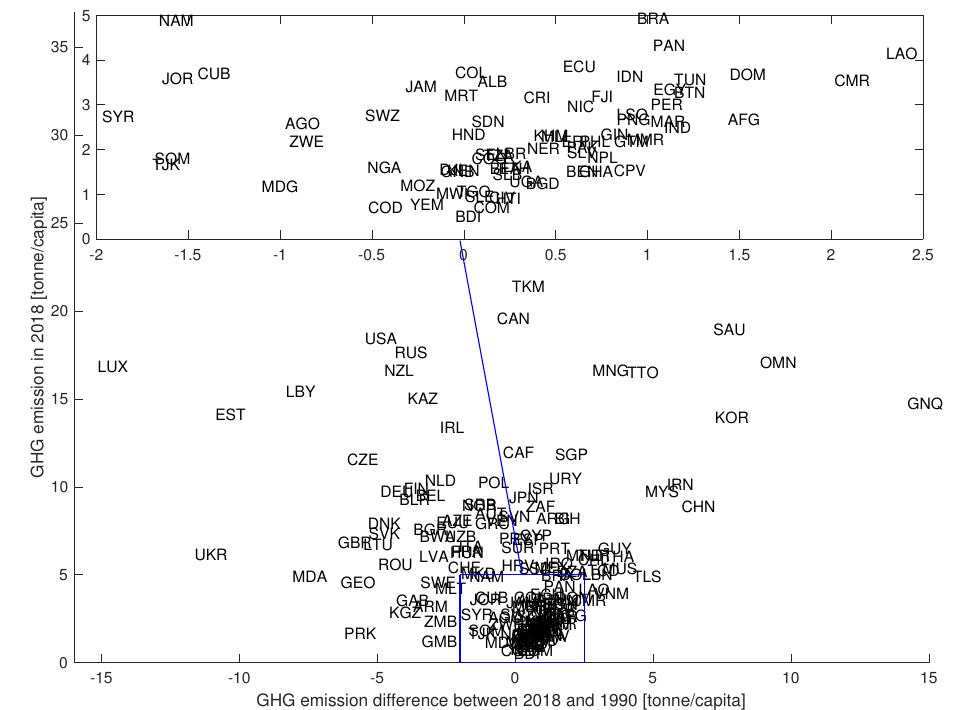
15 GHG emission difference between 2018 and 1990 [tonne/capita] Figure 11. This figure shows the GHG emission change between 2018 and 1990 of each country. Moreover, the actual level in 2018 can also be considered. Luxembourg reduced significantly in the studied period, but the country still produces a high level of GHG emissions. However, Ukraine also significantly reduced the GHG emissions, and the country produced a low level of GHG emissions in 2018. Meanwhile, Qatar increased the GHG emission very significantly and produced a high level of GHG emission in 2018. More countries are concentrated around zero on the positive side, which means that many countries have increased their emission slightly. However, this can be increased significantly in the